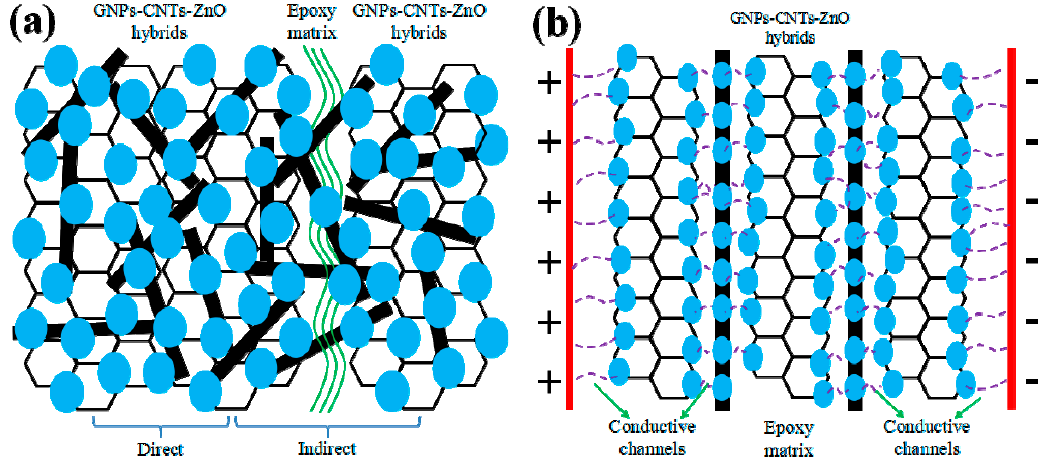
Figure 10. ( a ) Schematic illustration of GNPs-CNTs-ZnO hybrid in the composite and ( b ) the GNPs-CNTs-ZnO/ER structure at high applied voltage sweeps.